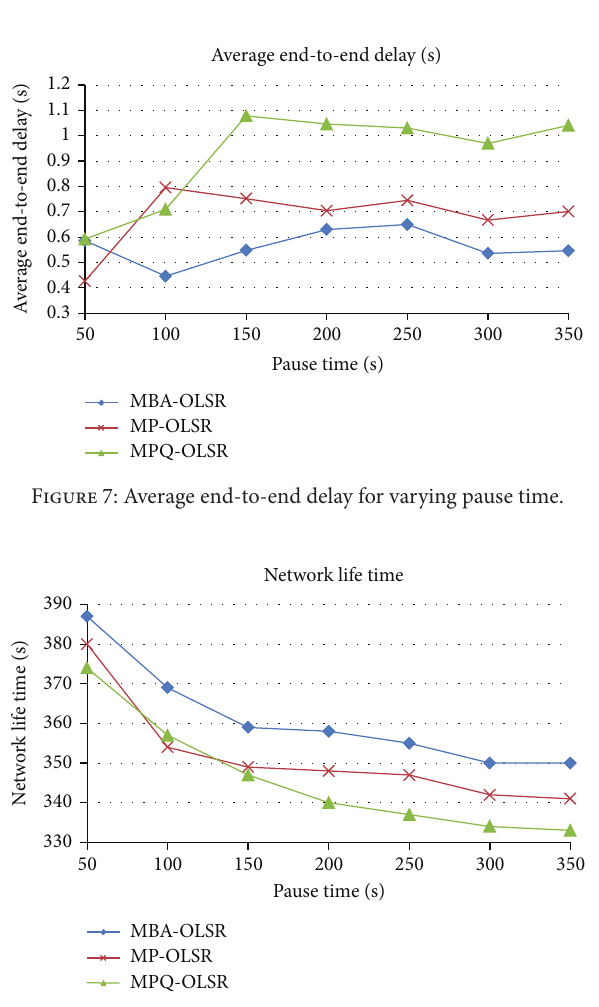
Figure 8: Network lifetime for varying pause time.